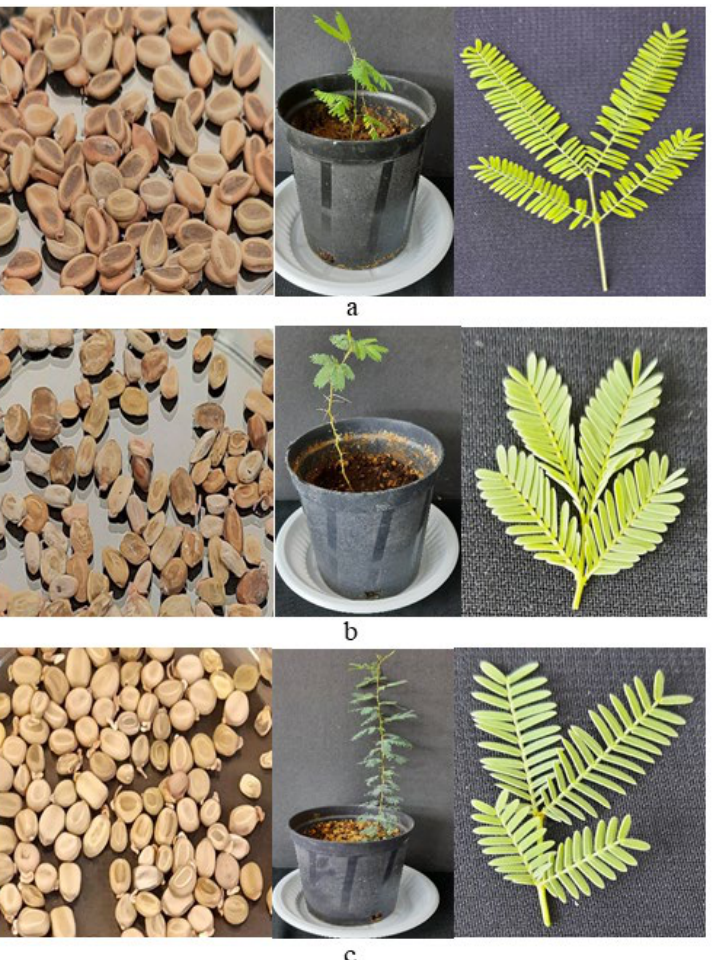
Figure 1. Acacia species; morphology of seeds measured in centimeters (cm), plant grown in a pot and leaf morphology (leaf length) measured in centimeters (cm) ( a ): A. johnwoodii ; ( b ): A. etbaica ; ( c ): A. origena .